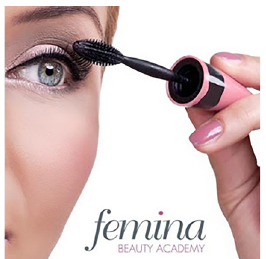
Figure 3: Sales Trend of Bays International; Source: Bays International (2017) Retail divisions at Bays